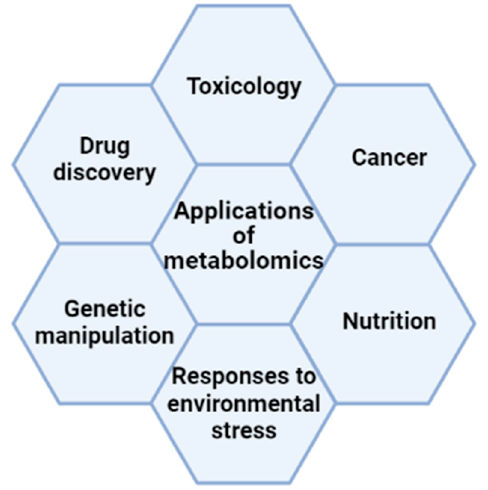
Figure 2. The main applications of metabolomics and their relationships.